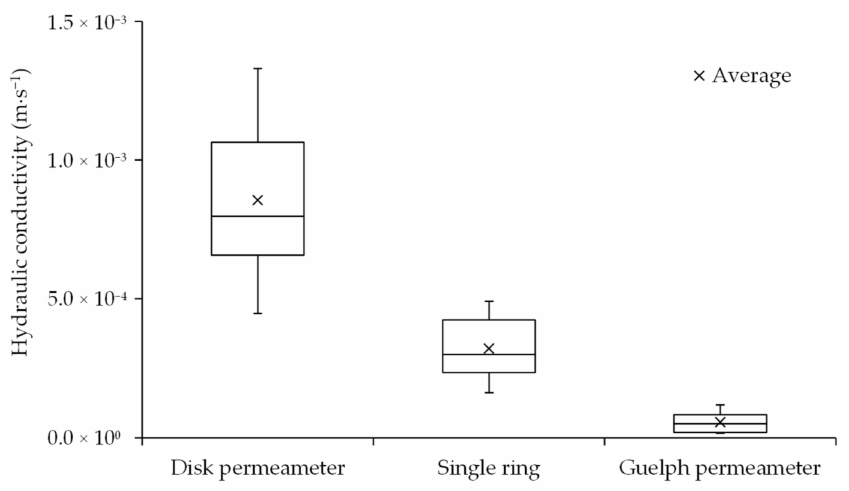
Figure 3. Differences in hydraulic conductivities determined by three different